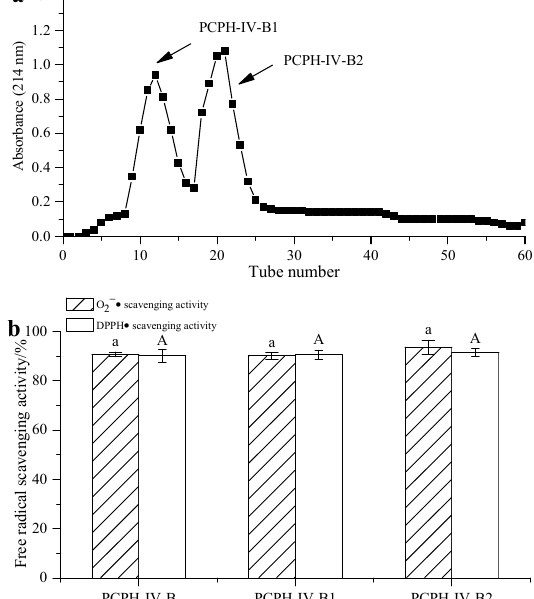
Figure 5. Separation of PCPH-IV-B by Sephadex G-15 gel chromatography: ( a ) chromatogram of PCPH-IV-B from Sephadex G-15 gel chromatography; ( b ) free radical scavenging activity of PCPH-IV-B fractions obtained from Sephadex G-15 gel chromatography. Identical same-case letters above the bars indicate no significant difference ( c = 20 mg/mL, p > 0.05).